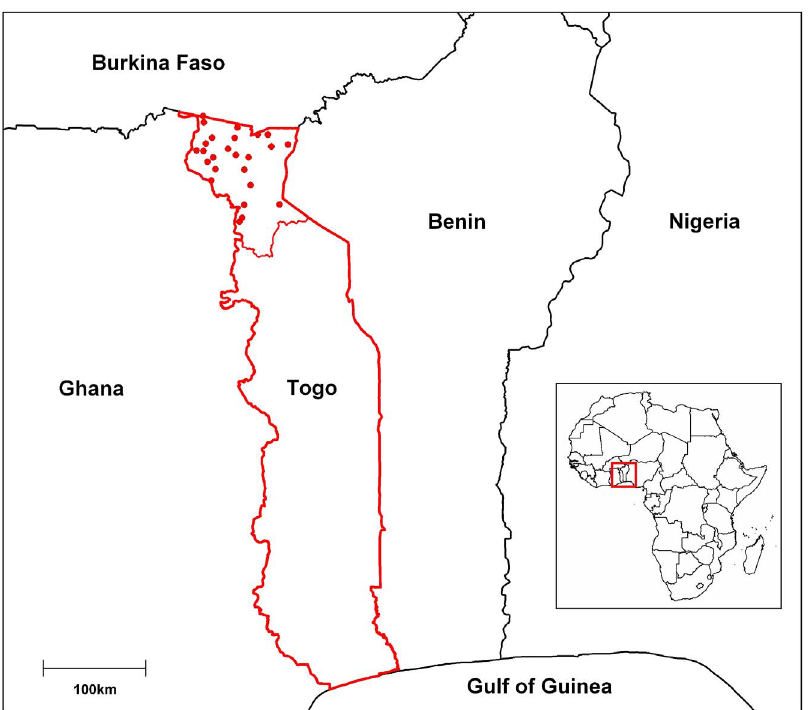
Figure 1. Map of study site. The national borders of Togo are shown in red and the boundary of the Savannah Region is indicated by the dashed red line. The red points correspond to the 25 randomly selected villages included in the survey.